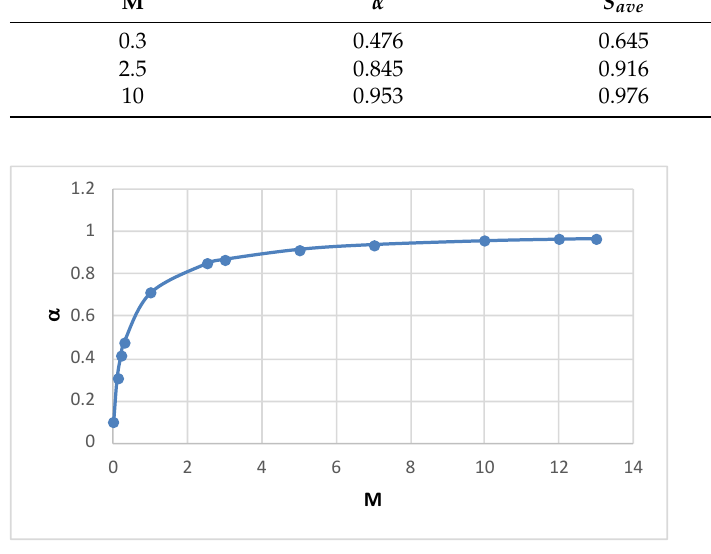
Figure 7. The root α as a function of the mobility